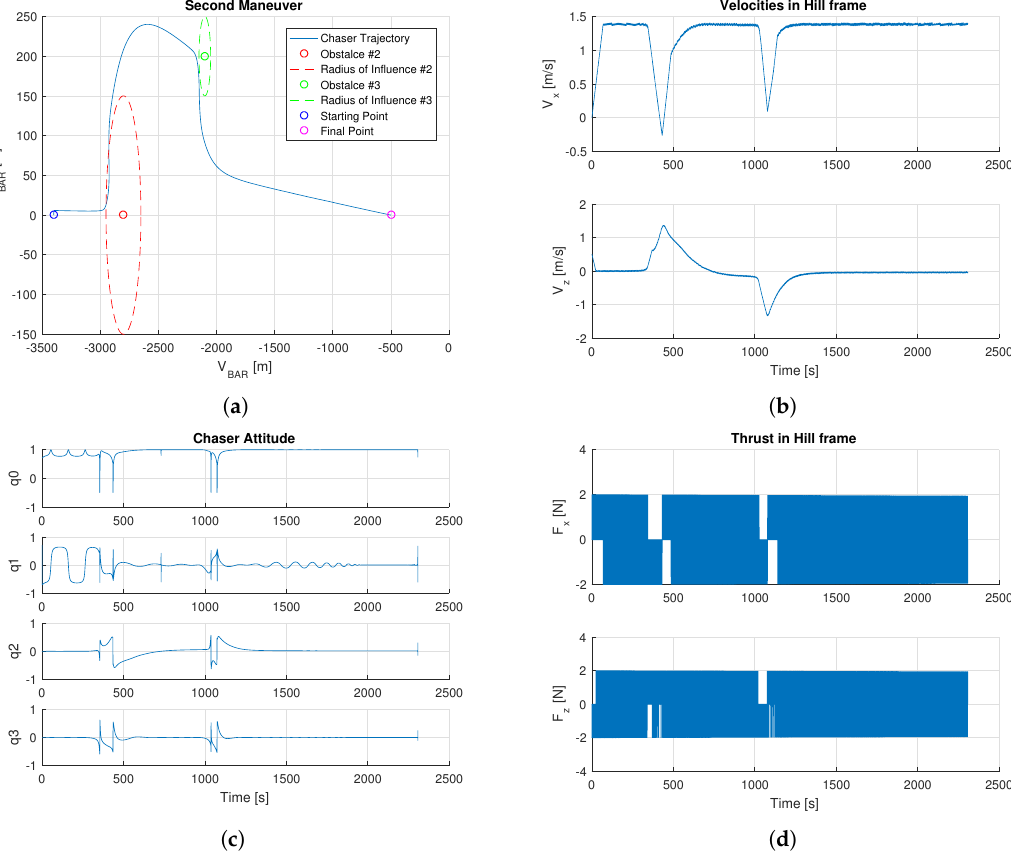
Figure 8. Second maneuver highlights for the SMC controller. ( a ) Second Maneuver: V BAR − R BAR plane. ( b ) Relative velocity. ( c ) Relative quaternion. ( d ) Thrust